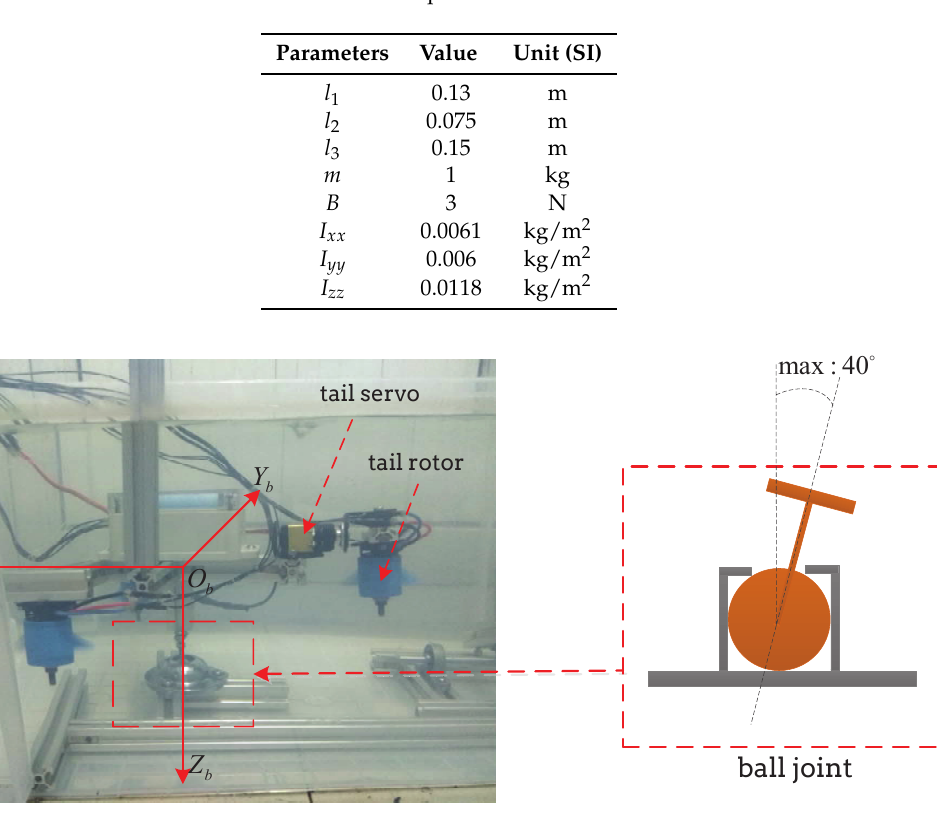
Table 1. Mechanical parameters of